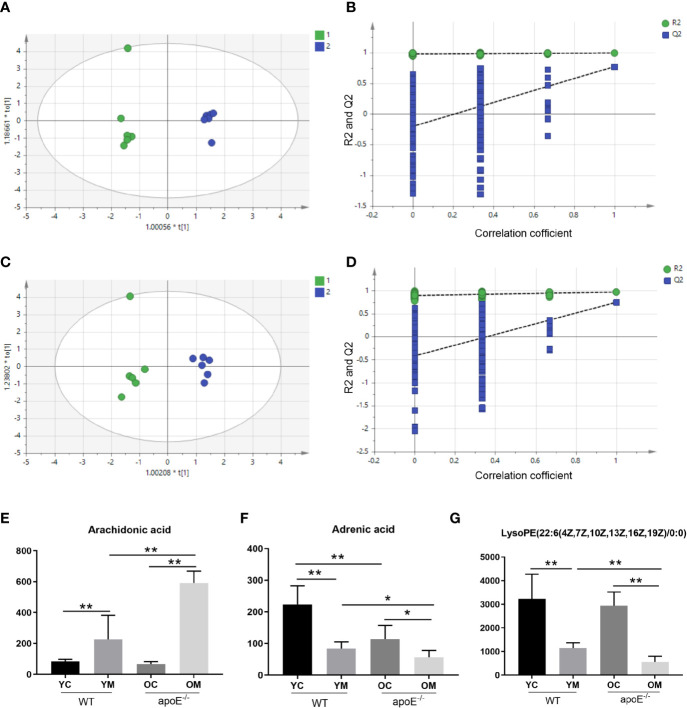
PLS-DA plots and validation plots for discriminating YM (1) and OM (2) in ESI+ and ESI- modes. (A) PLS-DA plot in ESI+ mode; (B) validation plot in ESI+ mode; (C) PLS-DA plot in ESI- mode; (D) validation plot in ESI- mode. Peak area of biomarkers in WT and apoE-/- groups mice in positive ion and negative ion modes: (E–G). PLS-DA, partial least squares discriminant analysis score; ESI+, electron spray ionization in positive; ESI-, electron spray ionization in negative; ESI, electron spray ionization; Q2, second quartile; R2, coefficient of determination; PLS-DA, partial least squares discriminant analysis score; horizontal axis t, principal component one; vertical axis t, principal component two. Data were shown as mean ± SD. *
p <0.05; **
p <0.01. p values are calculated from T-test, n=6.